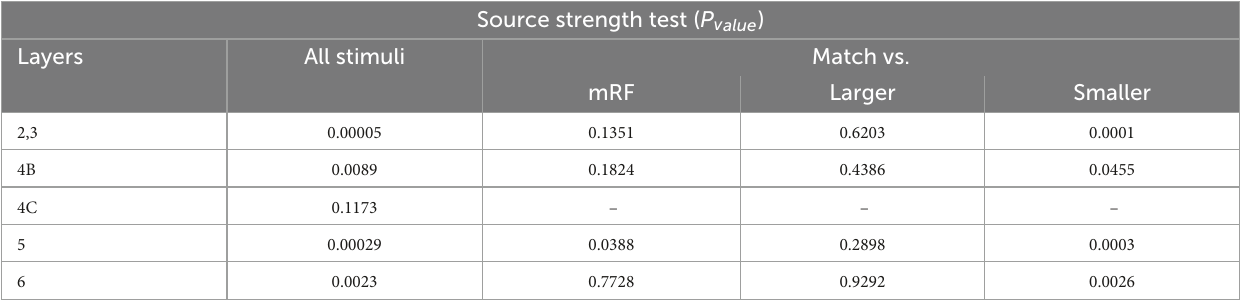
TABLE 3 The statistical test in each layer for source strength analysis.